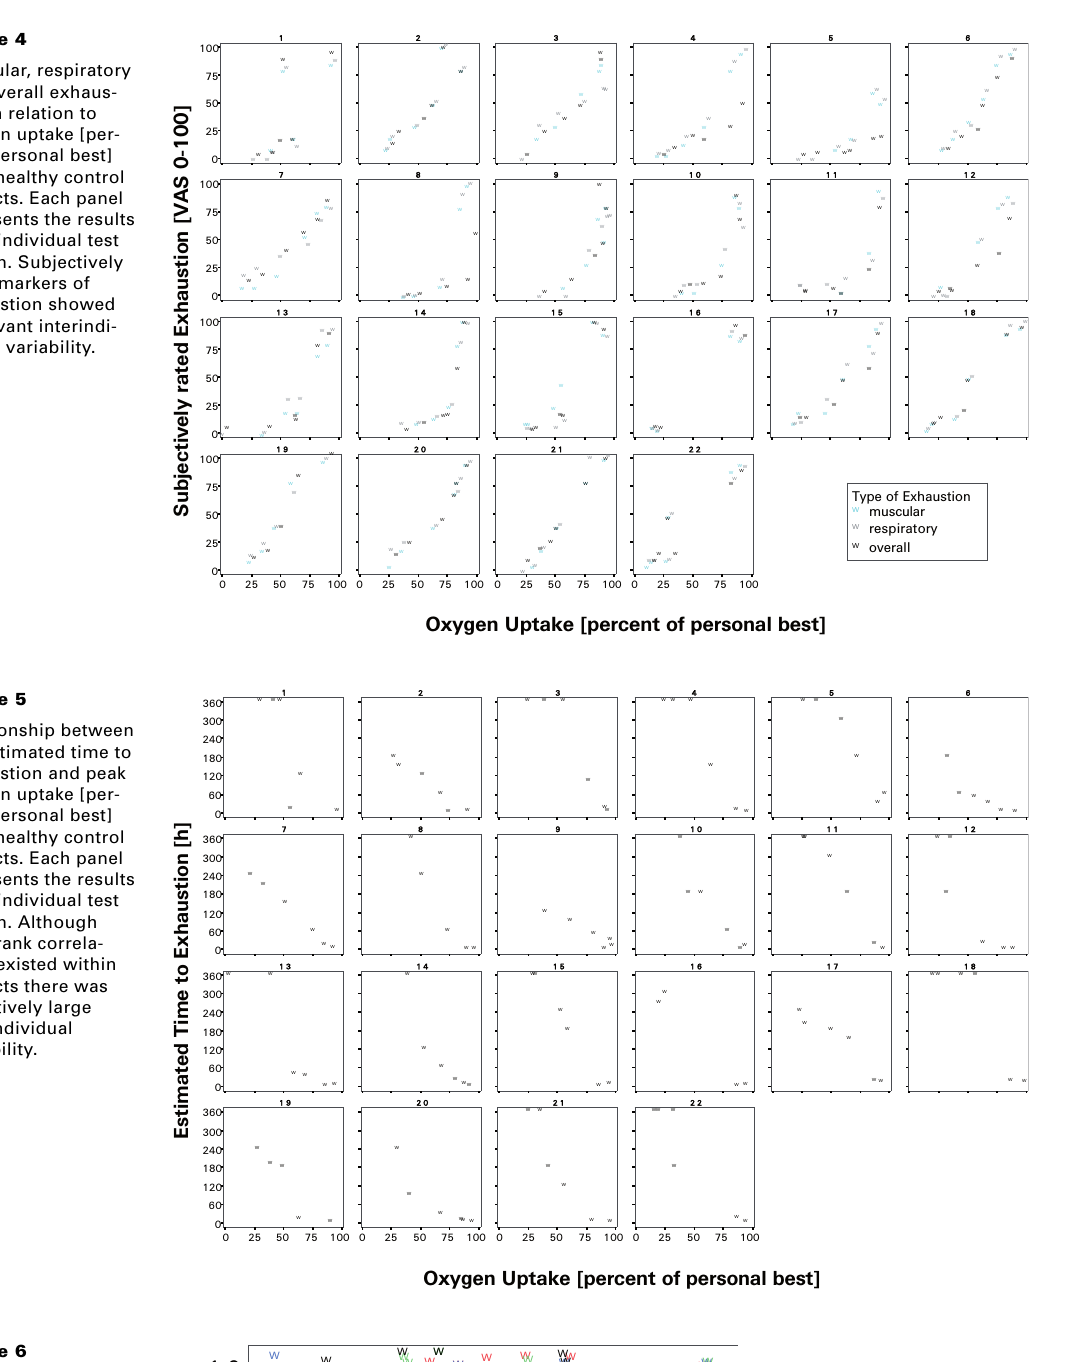
Scatter plot of rank correlation coeffi- cients (Spearman- Rho) between peak oxygen uptake [per- cent personal best] and subjectively rated markers of exhaustion, as well as the estimated time to exhaustion, in ab- solute values of all 22 heathly control individuals. Overall, within individuals the correlation coeffi- cients were typically >0.9. Only one indi- vidual (16) had some- what more difficul- ties in rating subjec- tive exhaustion and had correlation coefficients between 0.6 and